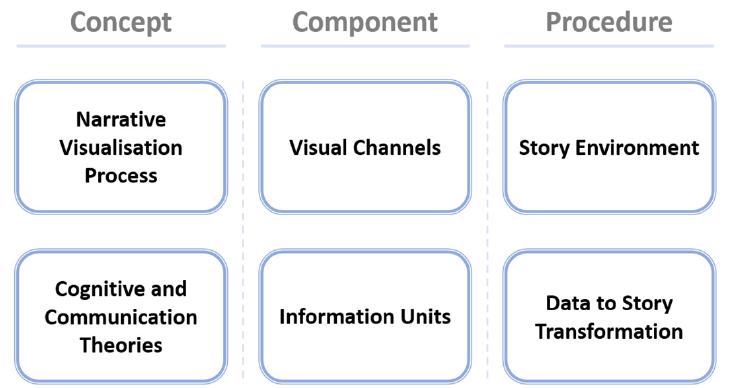
Figure 2. Key items of the visual data storytelling framework.